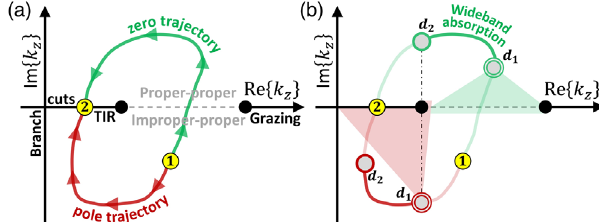
FIG. 9. SPP-APP pair location range for wideband absorption. (a) Sketch of the long-range SPP-APP pair (red-green) closed- loop root locus in the complex wave-vector domain ( k z ) as the film thickness decreases ( ∞ → 0 ), from creation or annihilation at the gold-air single-interface SPP wave vector to coalesce at the glass-air Brewster angle ( 1 → 2 ). (b) The tilt of their associated pole-zero pair (circles) with respect to the real axis ensures a film thickness range d 1 → d 2 for which the pole crossed under the total-internal-reflection (TIR) branch point and is mostly blocked from the observable (proper-proper) real (angular) axis, but the zero has not yet crossed above it, thus imprinting an absorption dip ranging from the critical angle to the grazing